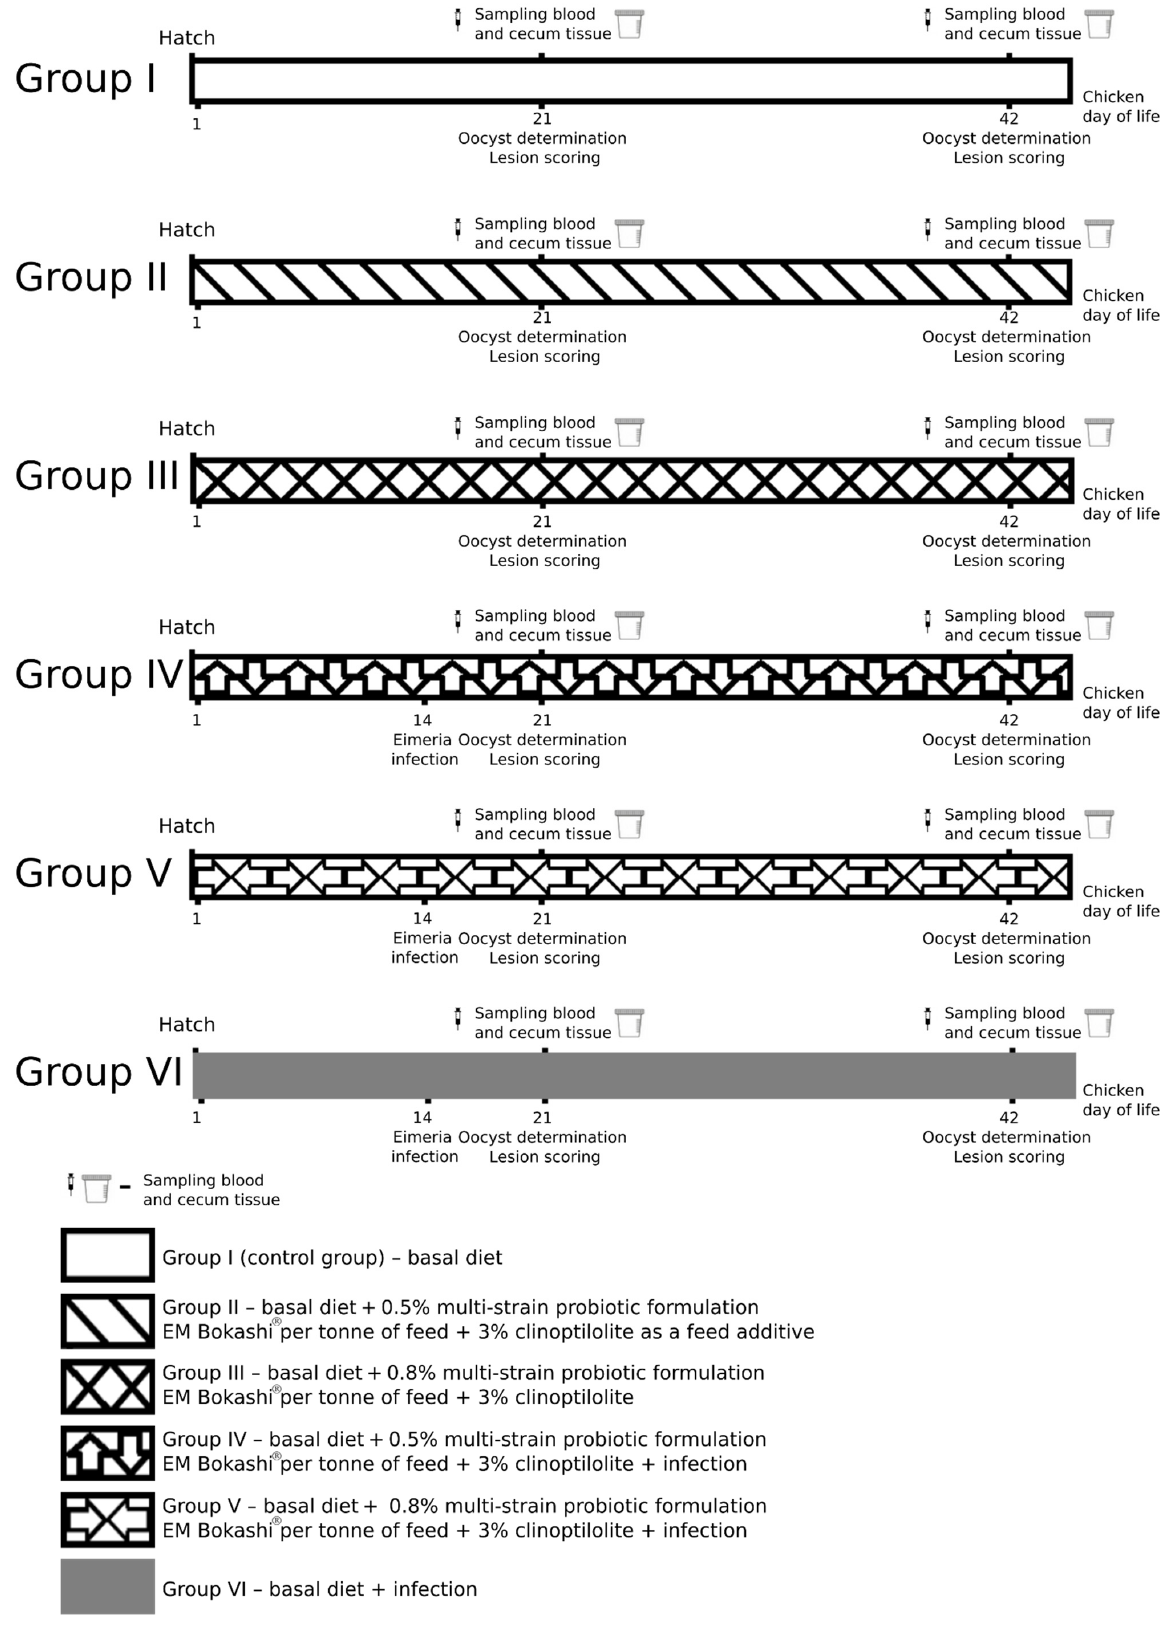
Figure 1. Experimental